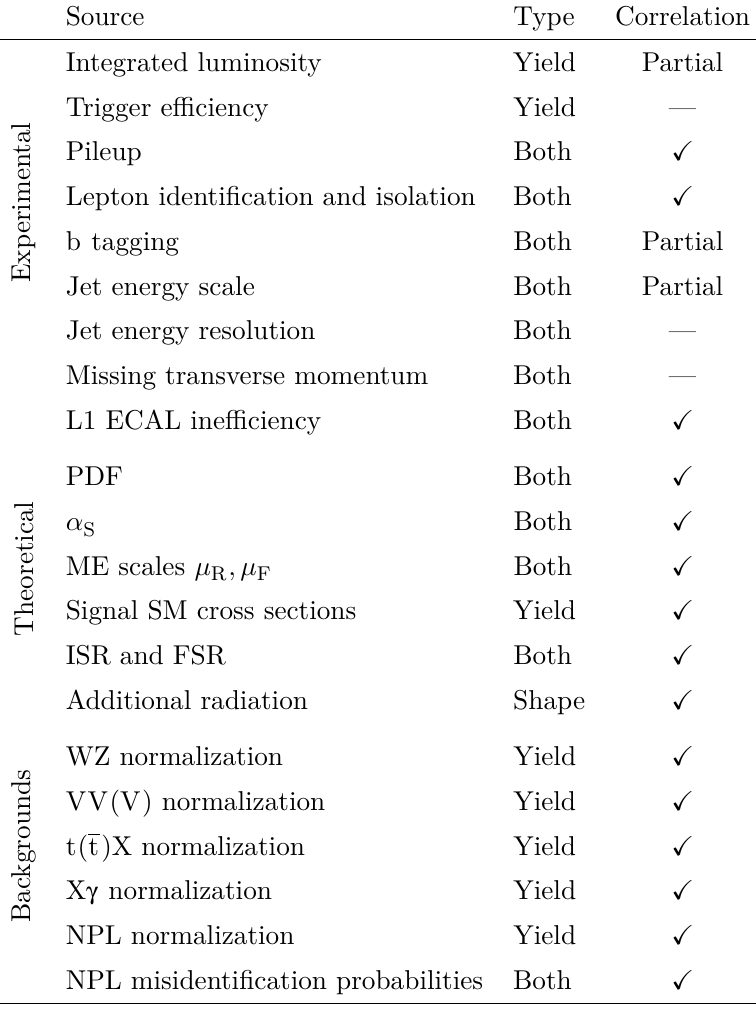
Table 4 . Summary of the different sources of systematic uncertainty included in the measurements. The first column indicates the source of the uncertainty. The second column indicates whether the source affects the event yields, the shapes of the observables, or both. In the third column, the sym- bols “ X ” and “—” indicate 100% and 0% correlations between the data-taking periods,